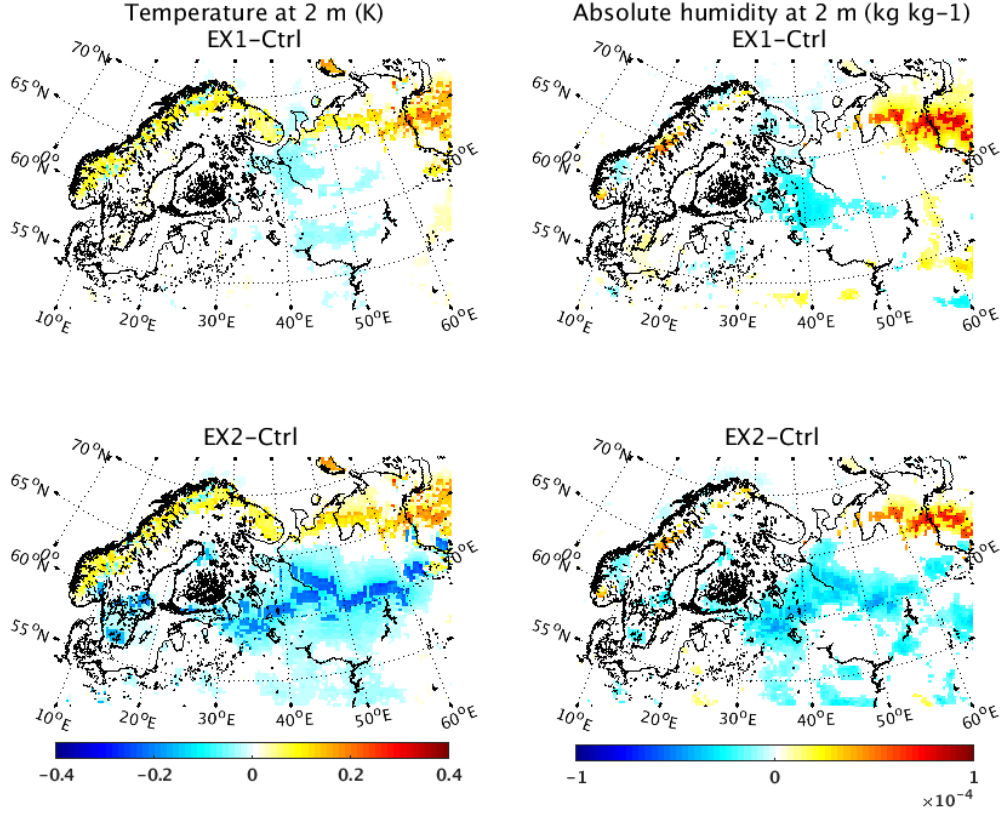
Figure 6. Changes in 10-year average near-surface variables as compared to the control run. Two-meter temperature change (left panels) and change in 2m absolute humidity (right panels). Ex 1 in upper panels; Ex 2 in lower panels (only showing significant results at the 95% confidence